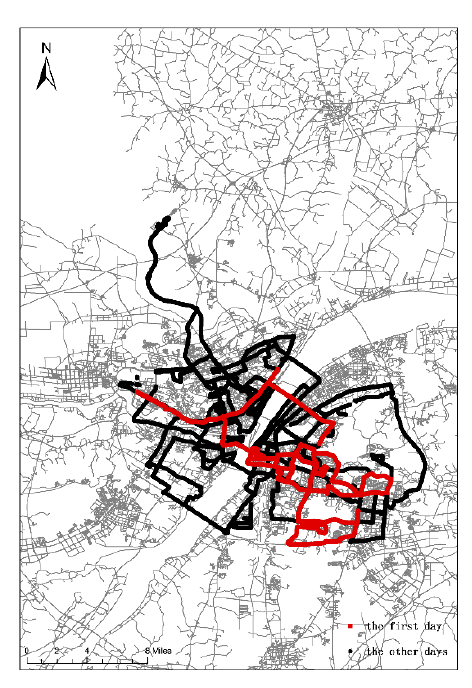
Figure 4. The first day’s driving trajectory